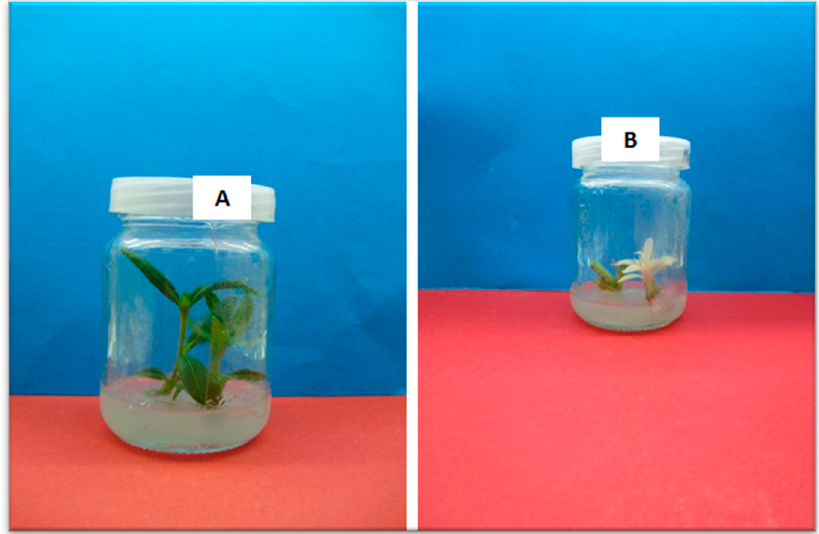
Figure 7. Albino phenomenon of in vitro propagated Jerusalem artichoke plant ( Helianthus tuberosus L.). Photo ( A ) = normal plantlets, whereas photo ( B ) = albino plantlets.